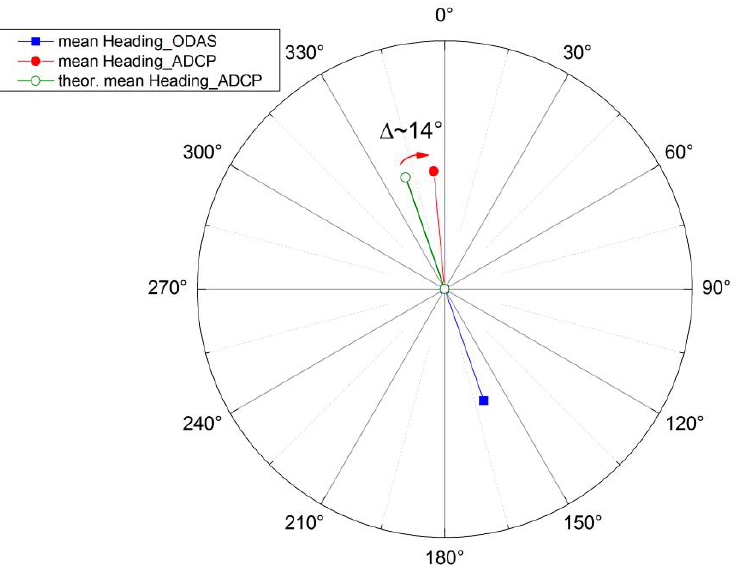
Figure 8. Average heading values detected by buoy and ADCP: the theoretical average value of the ADCP heading is obtained by overturning the average value of the ODAS heading by 180°.